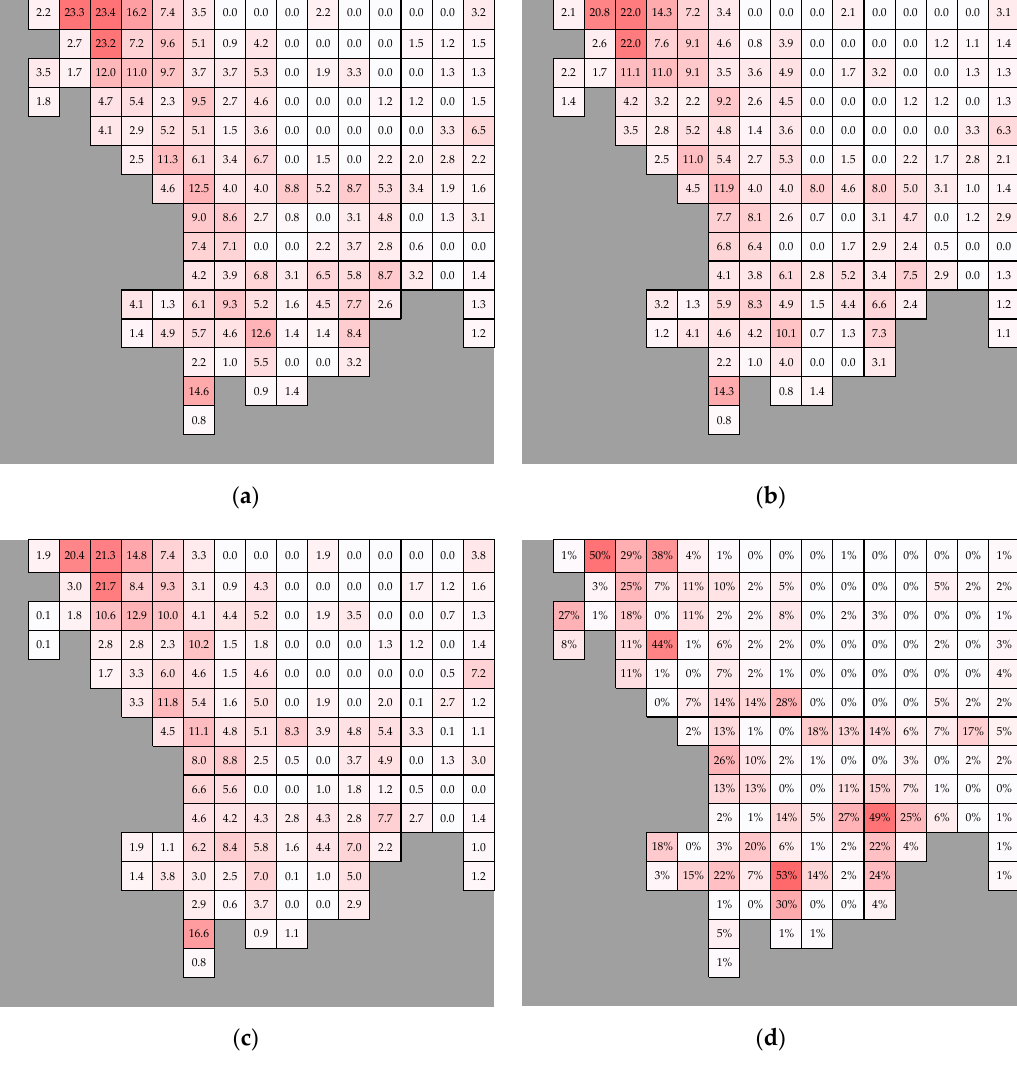
Figure 5. ( a ) Actual load density in year 2019; ( b ) Forecasted load density in year 2019 (P-SLF method); ( c ) Forecasted load density in year 2019 (BaU method); ( d ) Normalized absolute error in year 2019 (P-SLF method). Table 3. RMSE and MAE calculated for year